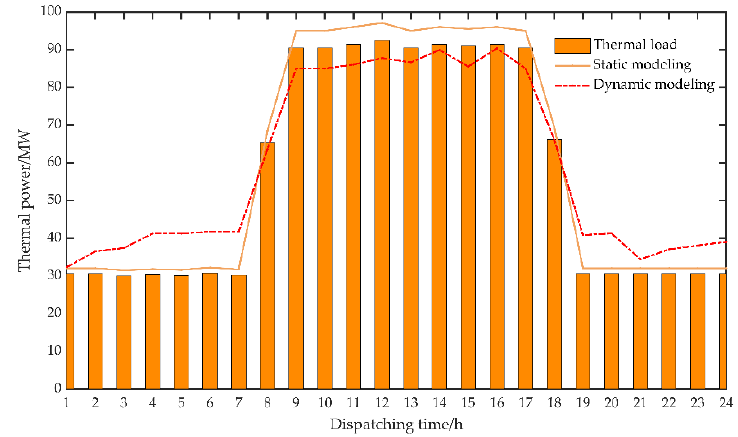
Figure 16. Thermal power under different models.